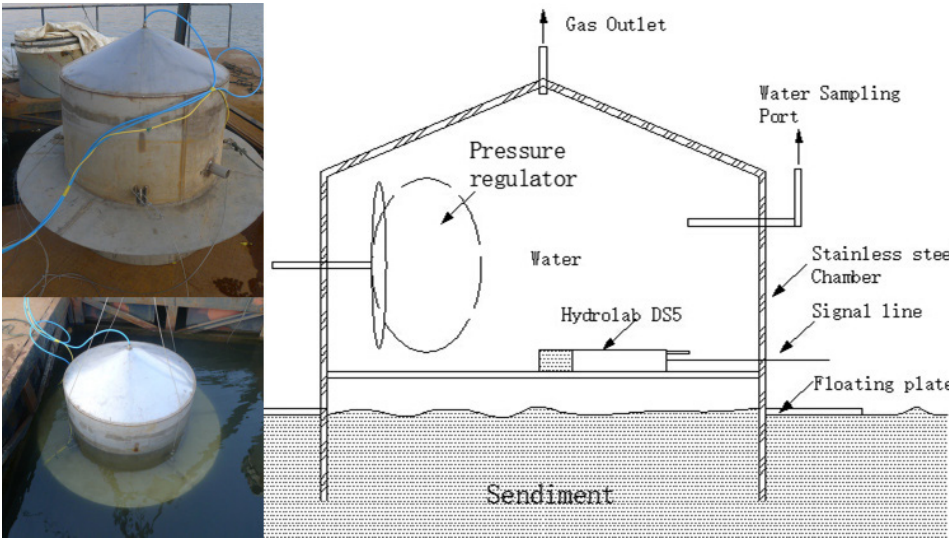
Figure 2. The schematic diagram of the in situ reactor and the photos of the experimental